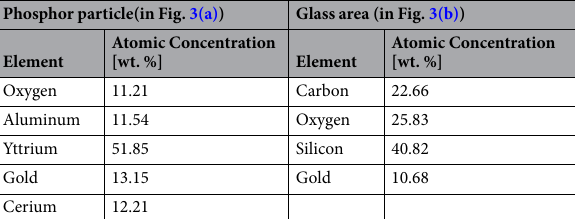
Table 1. EDS results of the phosphor particle and the glass area. EDS results are obtained using EDS model RONTEE at an accelerating voltage of 20